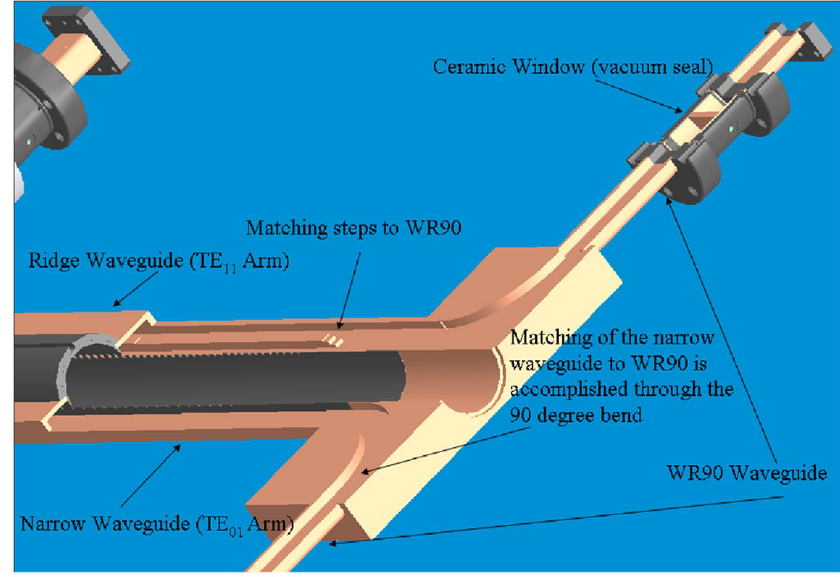
FIG. 5. (Color) Inner structure of the dual-mode directional coupler for system